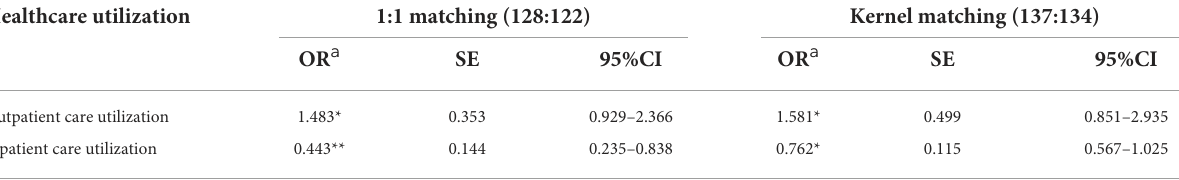
TABLE 3 Sensitivity analyses for the effects of community-based diabetes examination on healthcare utilization. Healthcare utilization